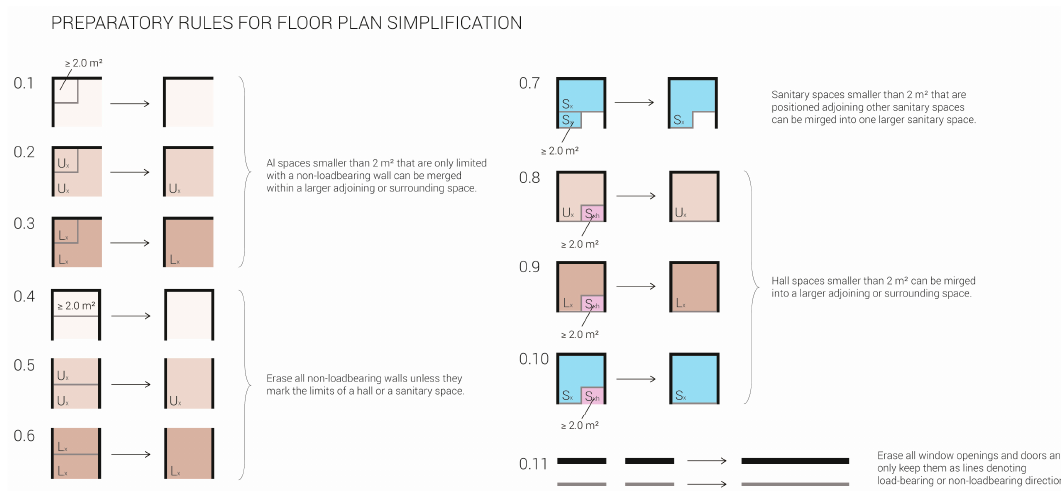
Figure 23. Preparatory rules (Ana Bel č i č ,